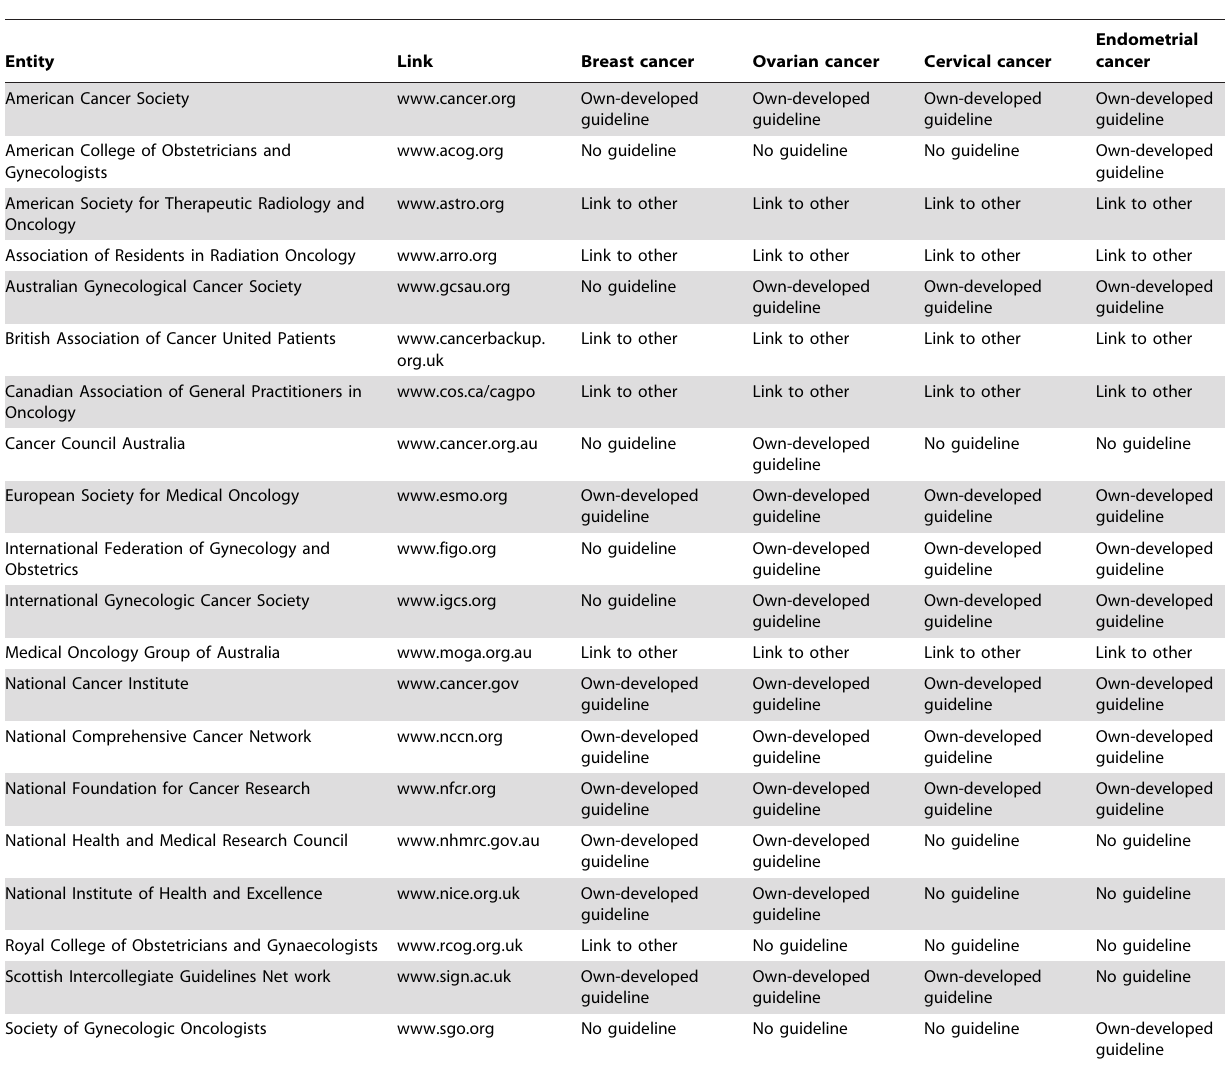
Table 2. Entities with guidelines for advanced stage gynecologic